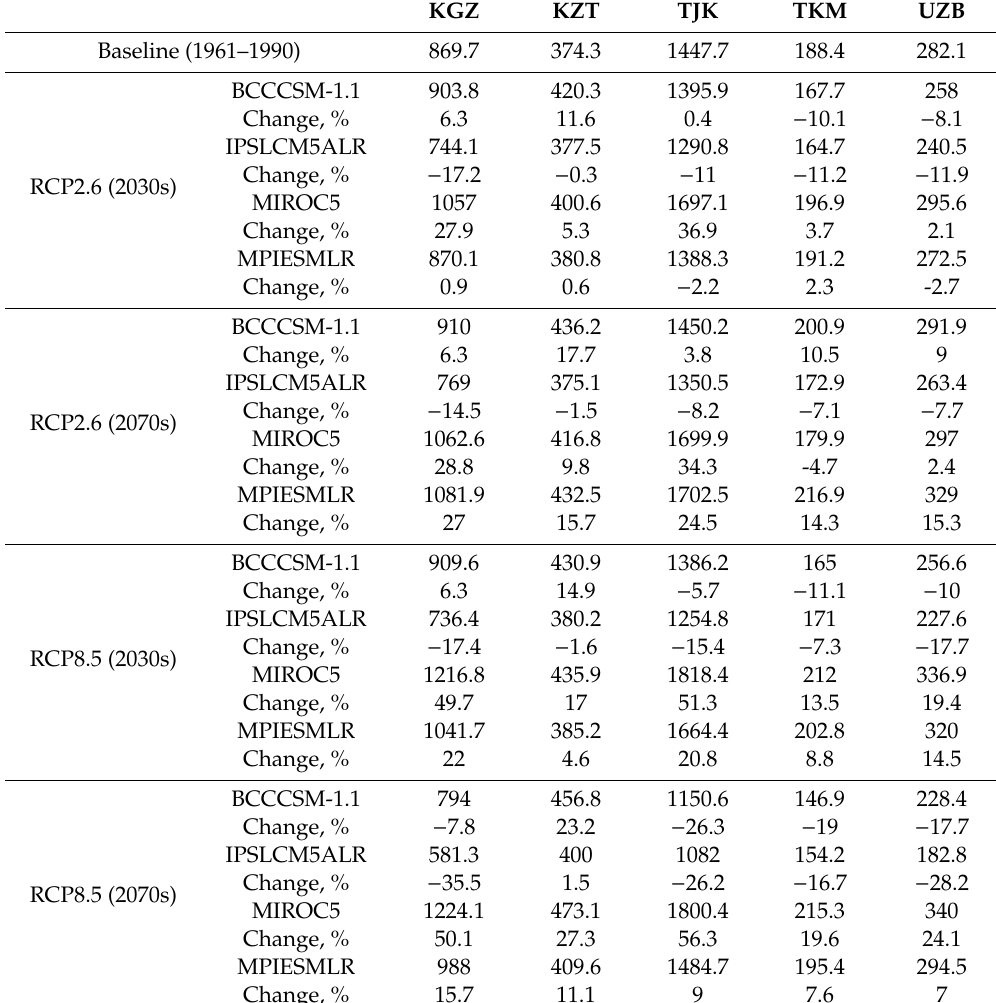
Table 3. Rainfall erosivity in Central Asia by country. Mean baseline and estimated (MJ mm ha − 1 h − 1 year − 1 ) by BCCCSM1.1, IPSLCM5ALR, MIROC5 and MPIESMLR with RCP2.6 and RCP8.5 emission scenarios models. Projected change to baseline